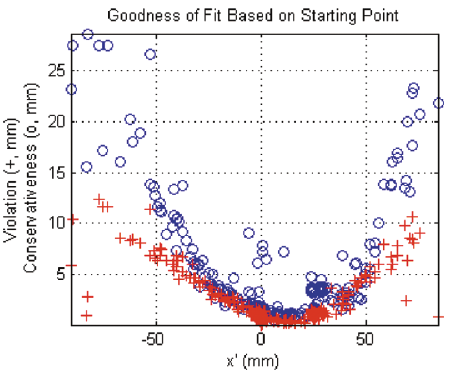
Fig. 16. The histograms for each boundary parameter of Eq. (7) shows that the scale of the error is small with respect to the scale of the fitting ellipse. Results represent 538